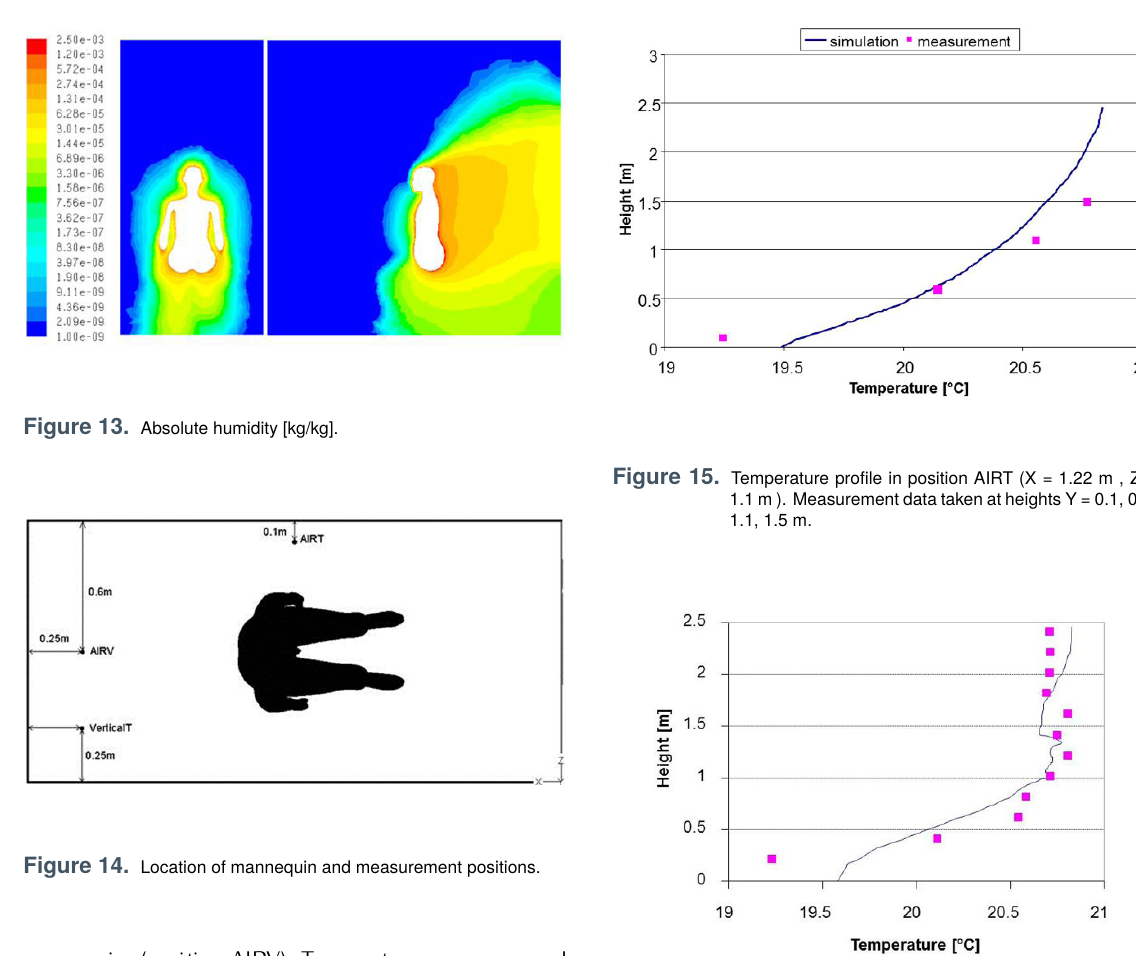
Figure 16. Temperature profile in position VerticalT (X = 2.19 m, Z = 0.25 m). Measurement data taken at heights Y = 0.2, 0.4, 0.6, 0.8, 1, 1.2, 1.4, 1.6, 1.8, 2, 2.2, 2.4